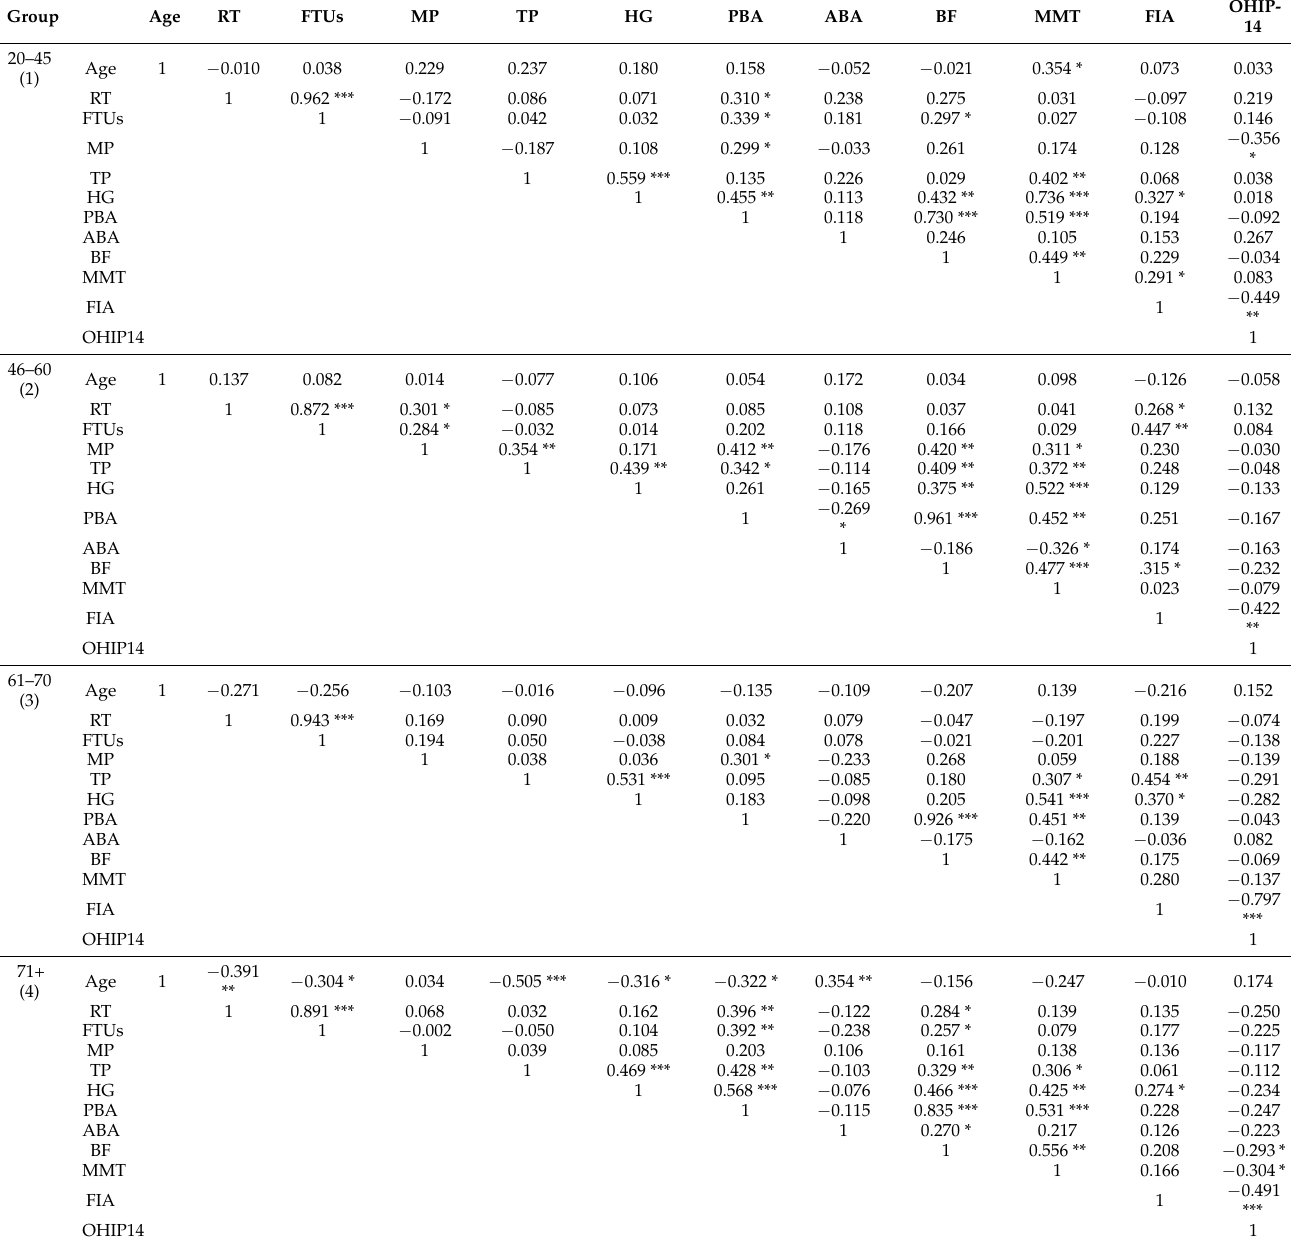
Table 3. Pearson’s correlation coefficient in each age